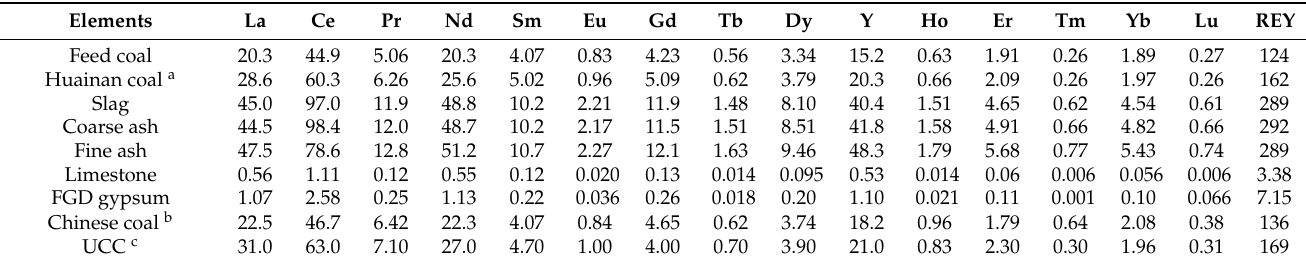
Table 3. Concentrations of REY in feed coal and its by-products from the WN power plant (units: mg/kg on an air-dried